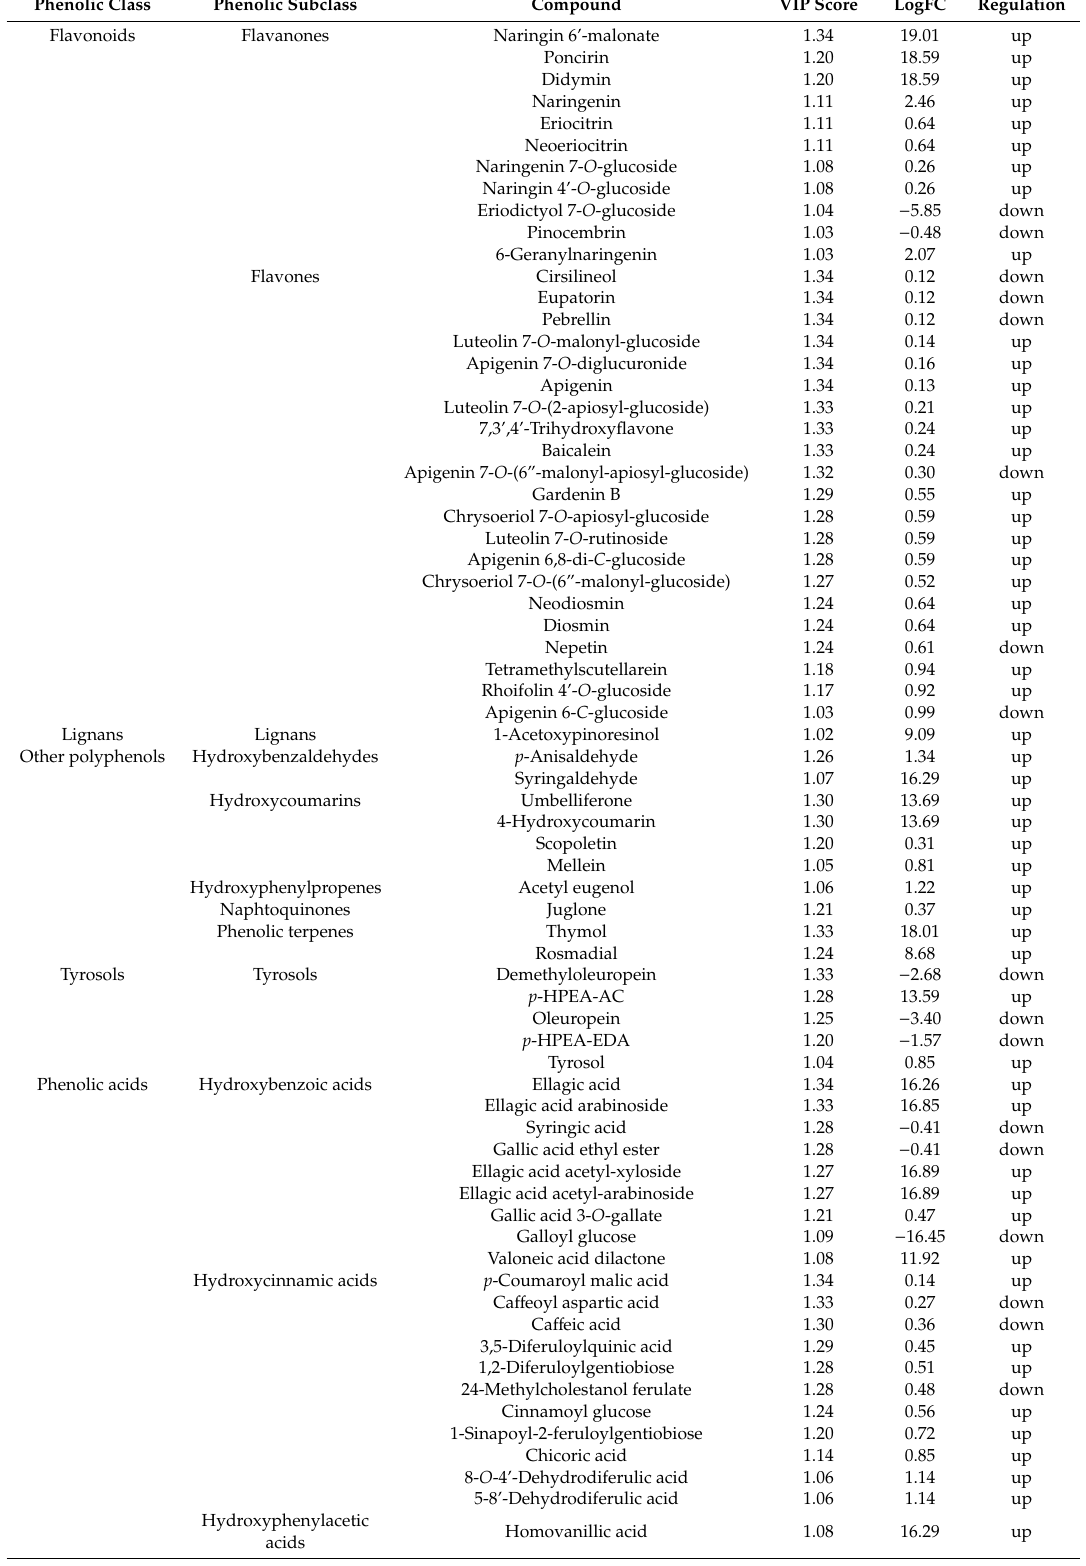
Table 2. Phenolic compounds discriminating EVOOCar vs. EVOO samples after 28 weeks of the storage process, grouped into phenolic chemical subclasses, as resulted by variable importance in projections (VIP) of OPLS-DA, together with the corresponding logFC